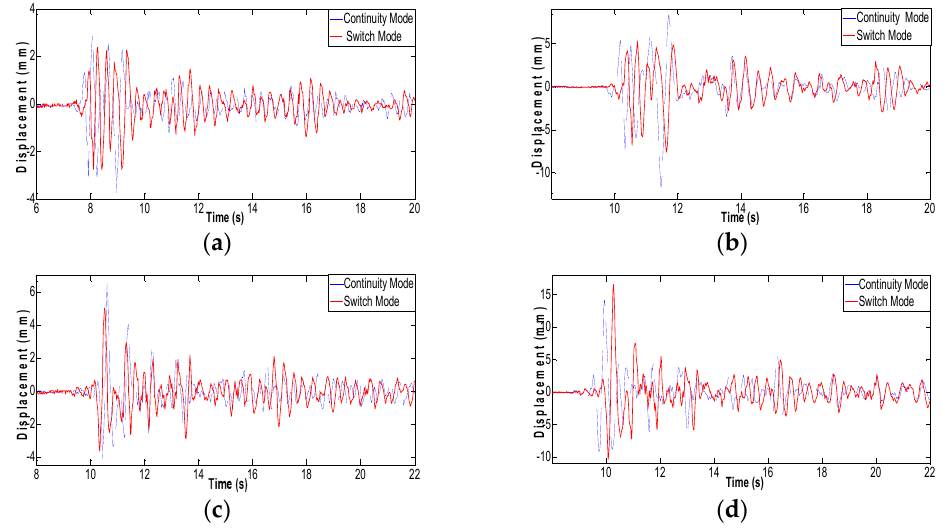
Figure 10. The displacement response of isolation layer. ( a ) El Centro earthquake—0.36 g; ( b ) El Centro earthquake—0.72 g; ( c ) Taft earthquake—0.36 g; ( d ) Taft earthquake—0.72 g.